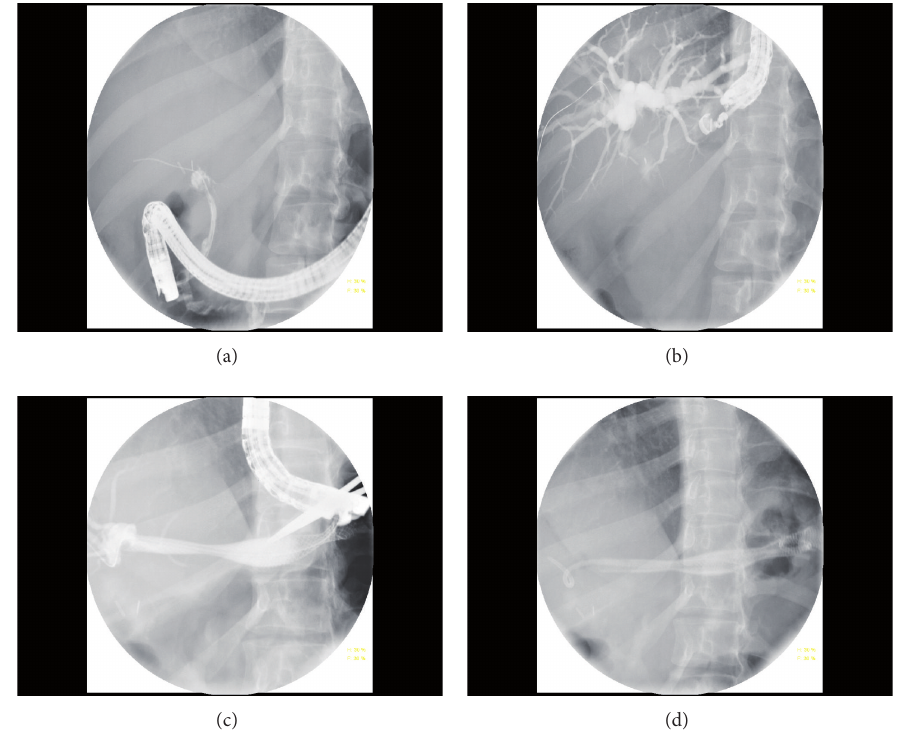
Figure 2: Transluminal stenting in a patient with common hepatic duct transection post-cholecystectomy. (a) Complete iatrogenic CHD obstruction at the site of cholecystectomy clips. (b) Initial cholangiogram with a 19-gauge needle via transgastric approach with passage of 0.025 󸀠󸀠 guidewire. (c) Placement of two 10 × 80 mm partially covered SEMS. (d) Placement of a 7Fr × 12cm double-pigtail plastic stent inside metal stents to prevent